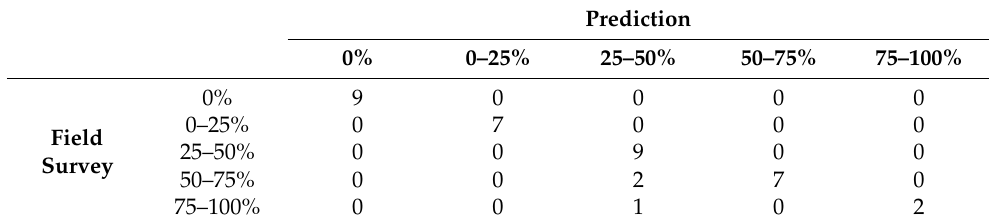
Table 8. Confusion matrix of the grids in the test